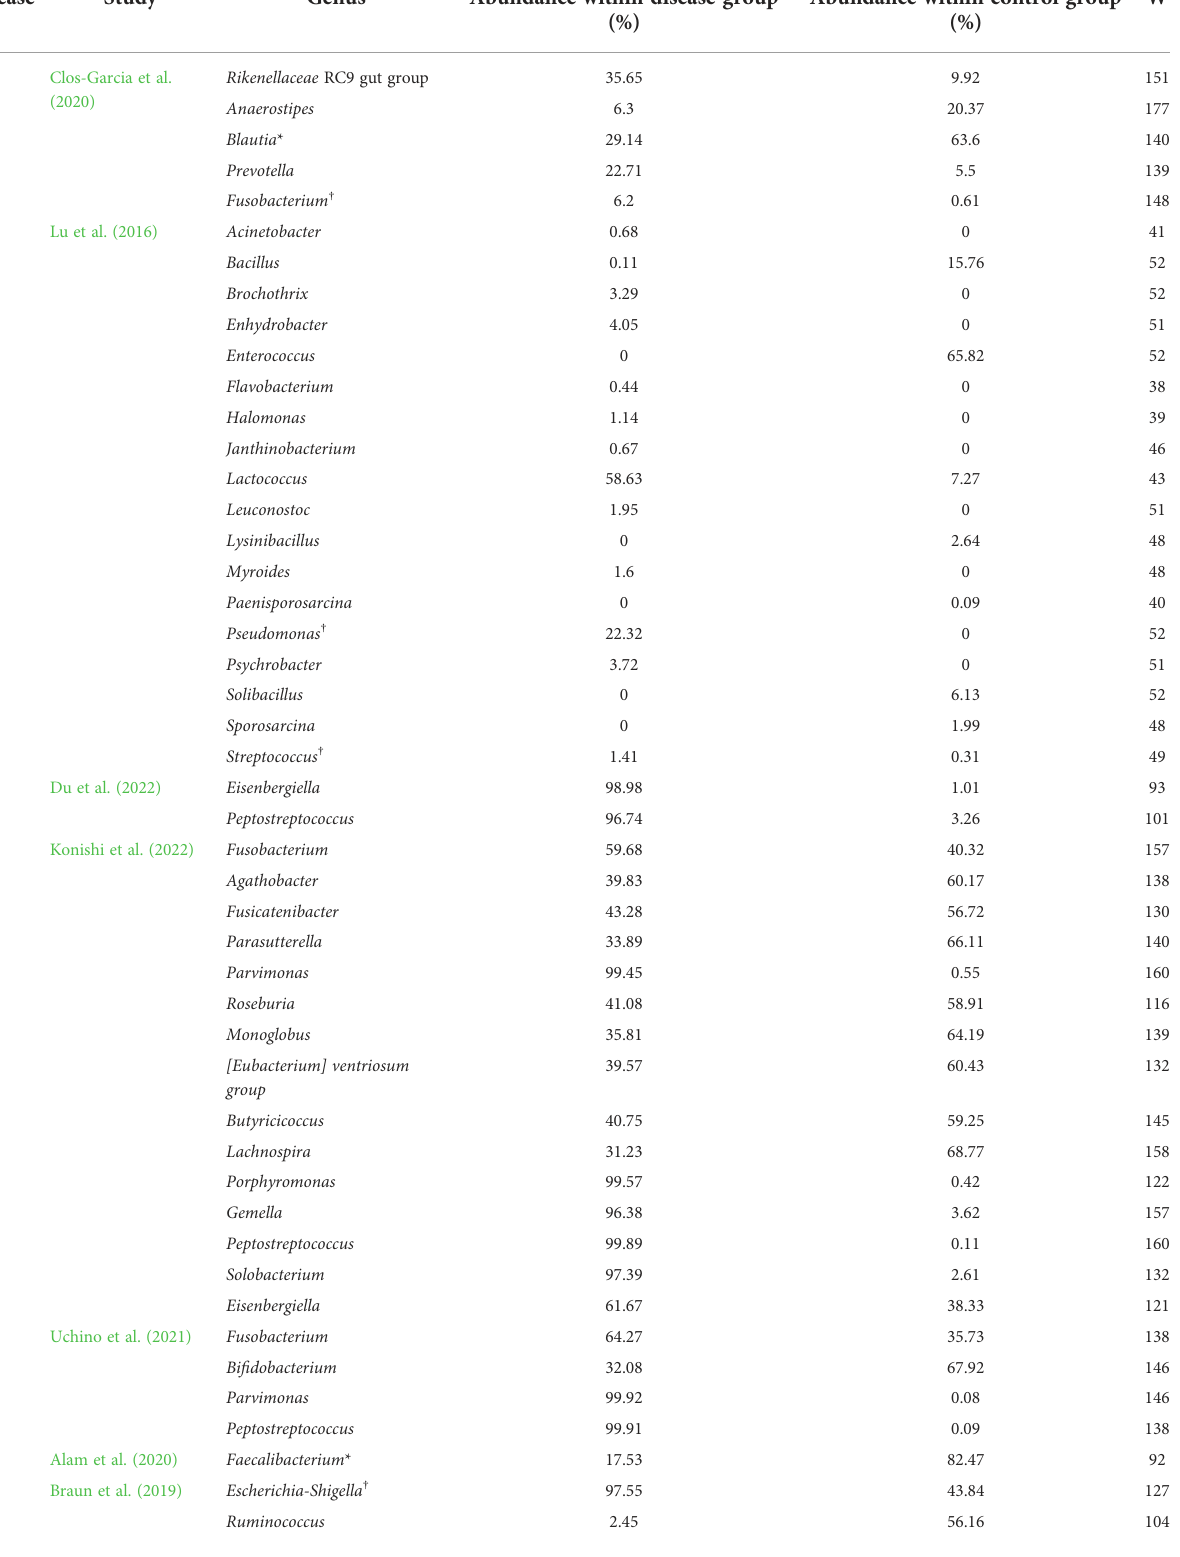
Abundance within control group W (%) (%)